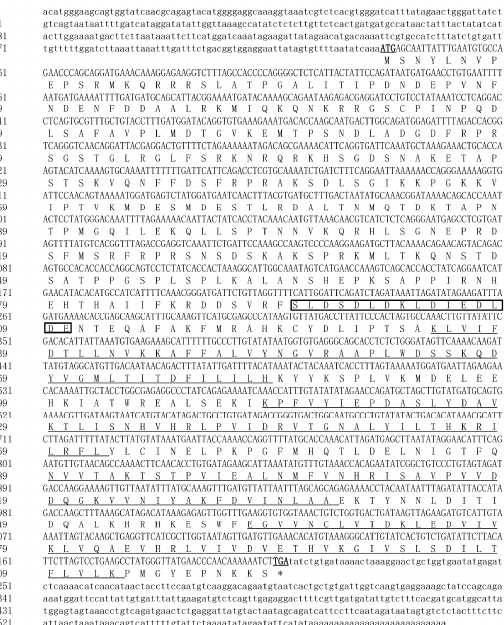
Figure 3. The nucleotide and predicted protein sequences of McAMPK γ . The black-framed region represents the low complexity domain, and the underlined areas represent the four CBS domain repeats.